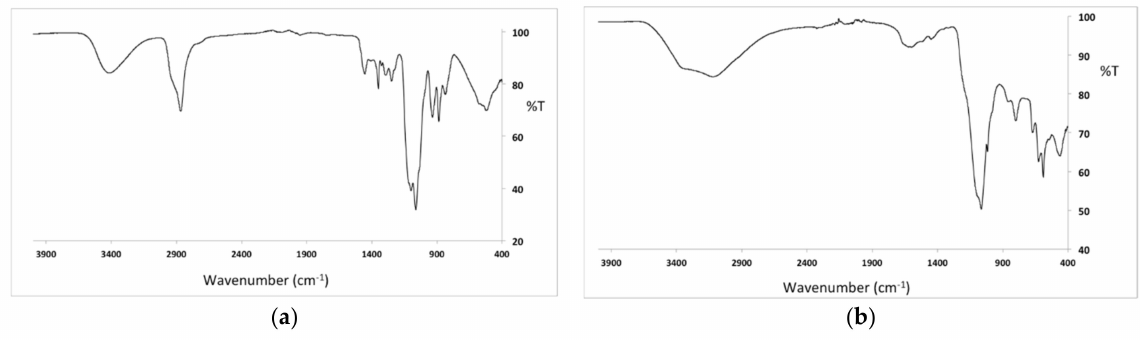
Figure 4. FTIR spectrum of Cu-CD ( a ) and CuCys-CD ( b ).